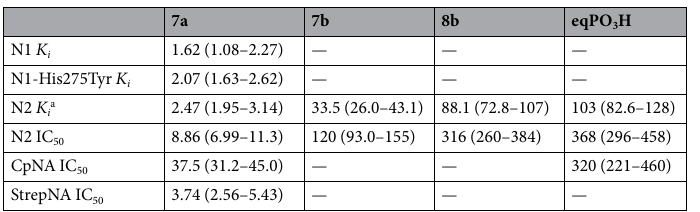
23 with the N2 = IC + [S]/ K 50 /(1 m ))